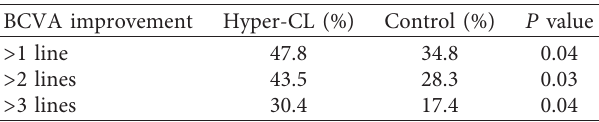
Figure 3: Anterior segment optical coherence tomography. The potential reservoir is demonstrated by anterior segment optical coherence tomography. Table 1: Proportion of patients improving > 1 line, > 2 lines, and > 3 lines in the Hyper-CL and bandage contact lens groups.